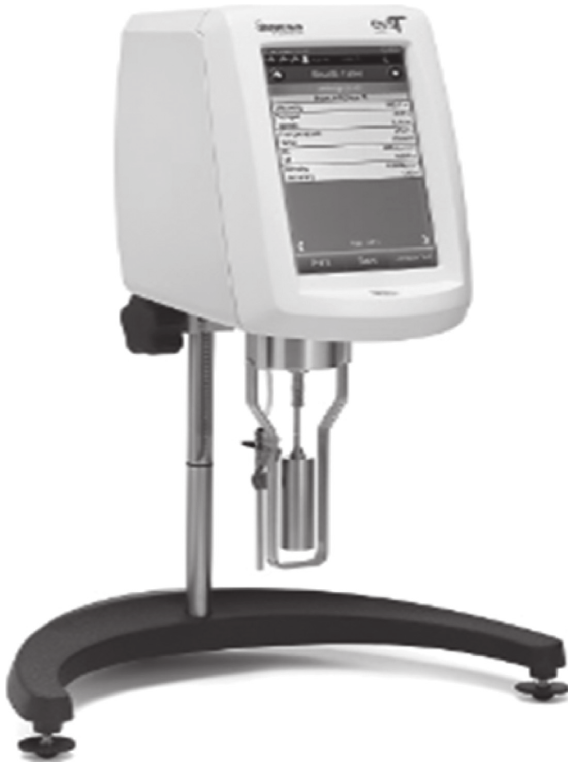
Figure 6: Dynamic rheological